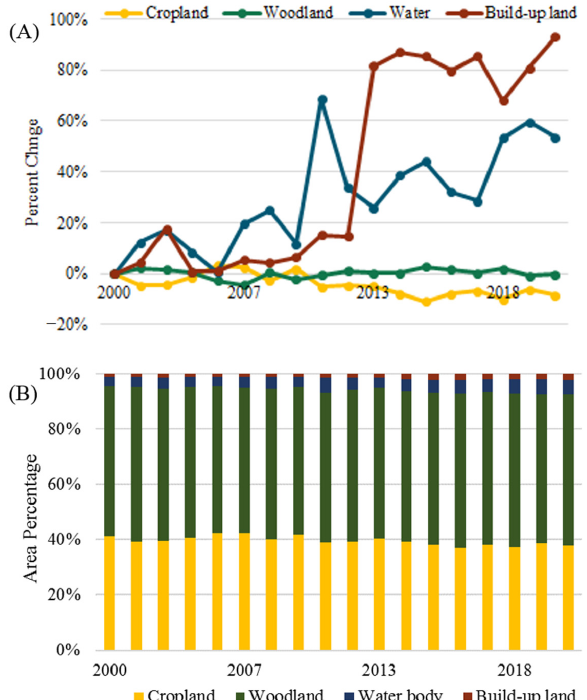
Figure 5. Change tendencies ( A ) and area percentages ( B ) of various land use/land cover types from 2000 to 2020. Specifically, the largest increase in the study area was built-up land (0.35 × 10 4 km 2 , 93.49%). The rapid increase in construction land mainly occurred after 2011. The area of water bodies also showed a continuously increasing trend (0.59 × 10 4 km 2 , 54.19%). The area of woodland only showed a slight change. However, the area of cropland showed a